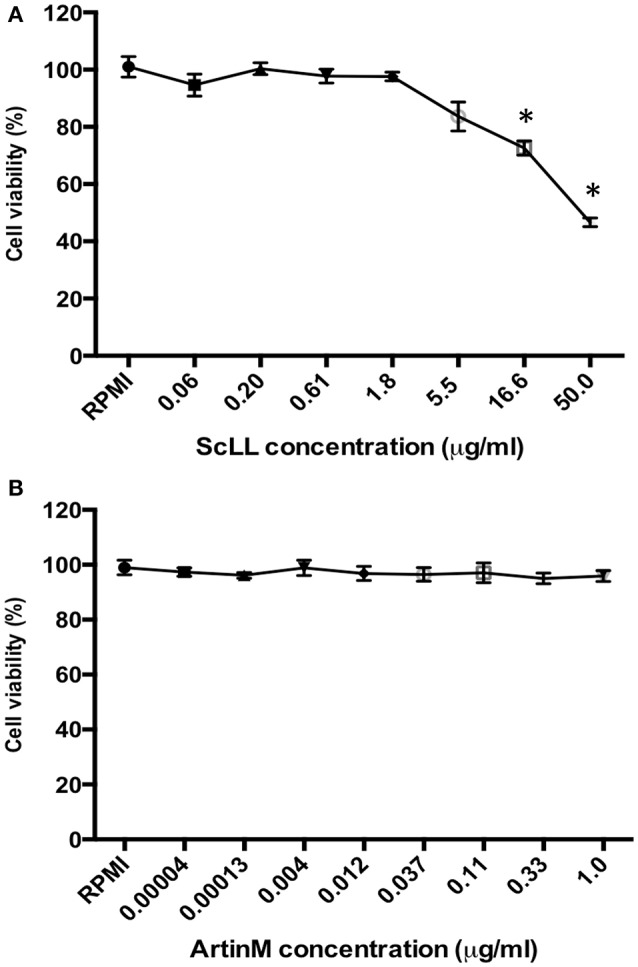
Cell viability determined by MTT assay in murine bone marrow-derived macrophages (BMDMs), treated with ScLL (A) or ArtinM (B) in several concentrations, ranging from 0.06 to 50 μg/ml or from 0.00004 to 1 μg/ml of ScLL or ArtinM, respectively. The cell suspensions were cultured in RPMI-1640 medium and the data are representative of one from three independent experiments. *P < 0.05.